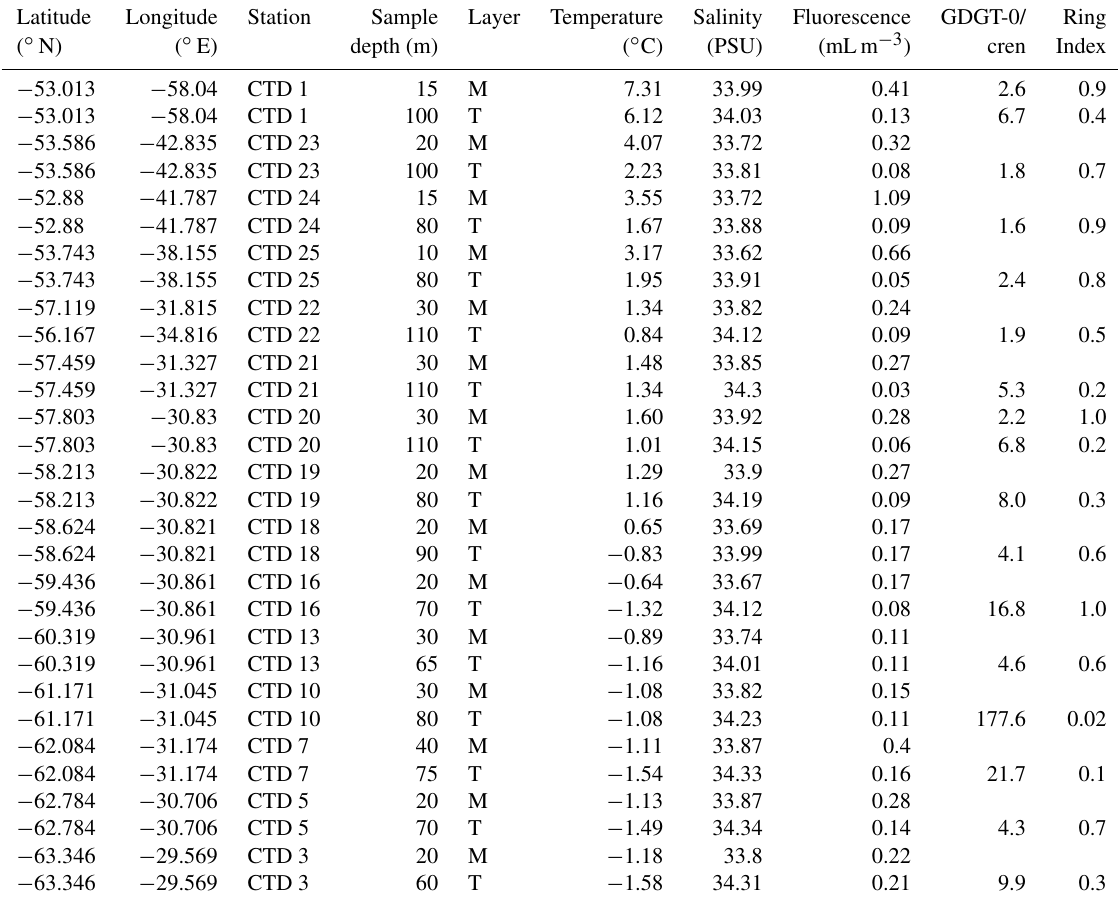
Table 1. Scotia Sea SPM samples studied and their physical properties including sample depth (m) and sample layer where “M” denotes mixed layer and “T” denotes thermocline layer, GDGT-0 / cren, and Ring Index. Latitude Longitude